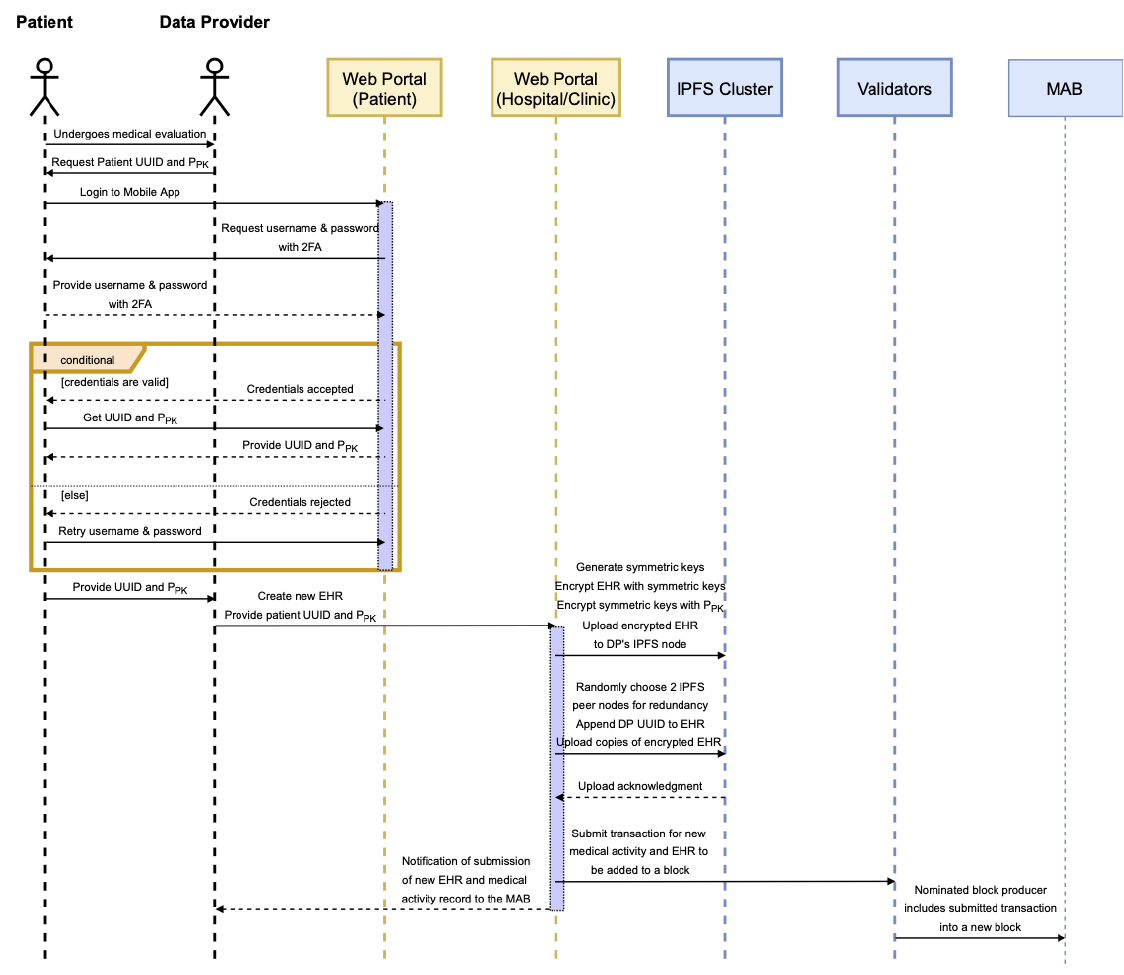
Figure 17. EHR creation and storage sequence diagram.